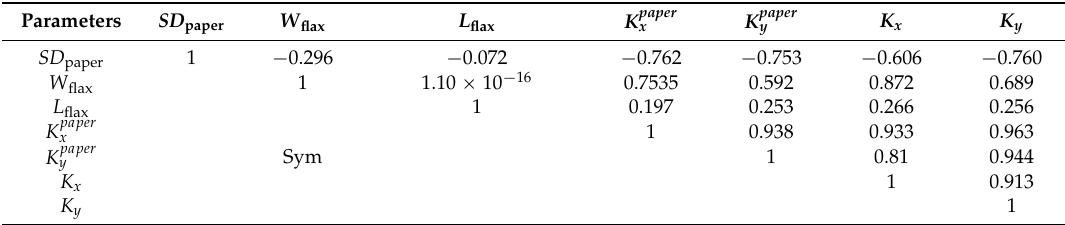
Table 5. Coefficients of the correlation matrix.